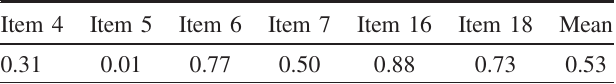
TABLE III. Agreement coefficient κ between the expert rating and the algorithmic classification of the